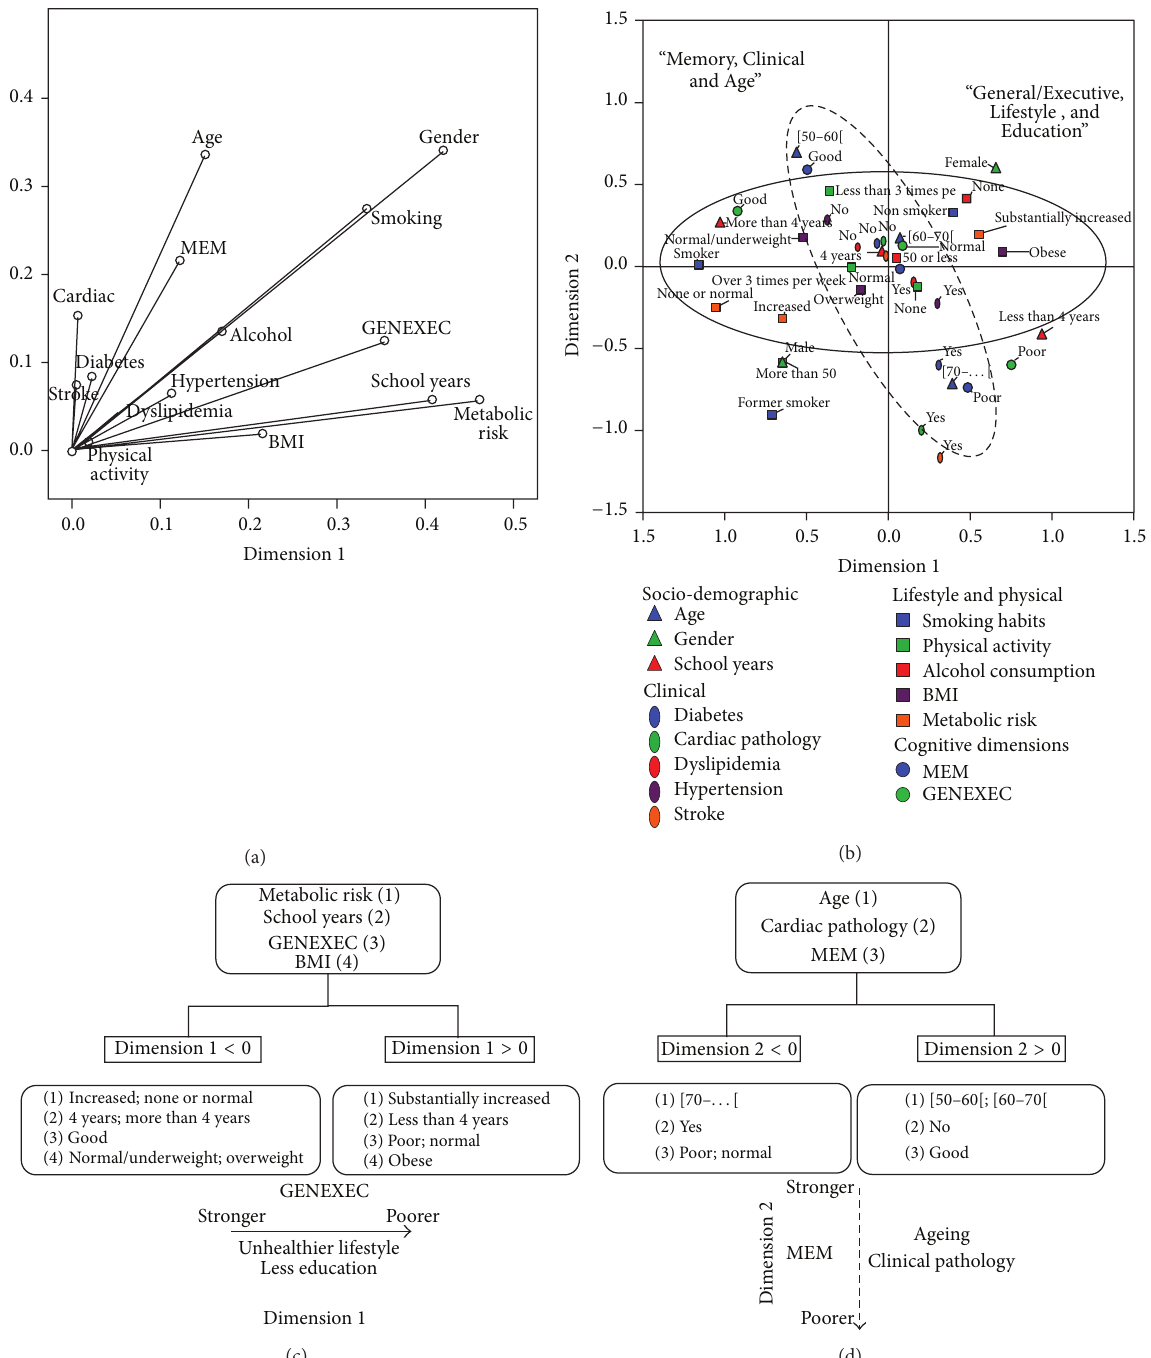
Figure 1: MCA dimensions. (a) MCA dimensions discrimination measures. (b) Joint category plot of the explored variable categories. (c) Positive and negative centroid coordinates for dimension 1. (d) Positive and negative centroid coordinates for dimension